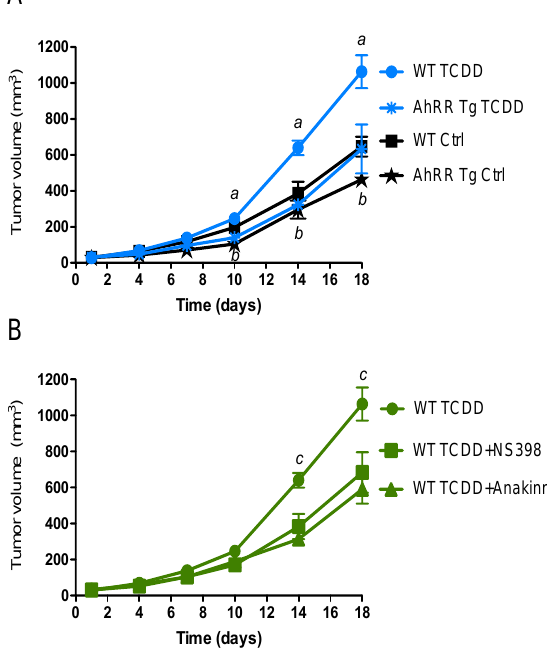
Figure 1. Suppressed tumor growth of EL4 lymphoma cells in AhRR Tg mice. Tumor volume of 10-week-old AhRR Tg mice and littermate WT mice ( n = 6 for each group) following subcutaneous injection with EL4 lymphoma cells is shown. ( A ) After 24 h mice were treated with corn oil (Ctrl, black lines) or i.p. injected with 10 µ g / kg TCDD (blue lines). ( B ) WT mice were treated with NS398 or Anakinra (green lines) 30 min. before and every 4 days after injection of TCDD. Tumor volume was measured over a period of 18 days. Means of tumor volume are shown. a significantly higher than AhRR Tg TCDD. b significantly lower than WT Ctrl. c significantly higher than mice treated with NS398 or Anakinra. ( p < 0.01).